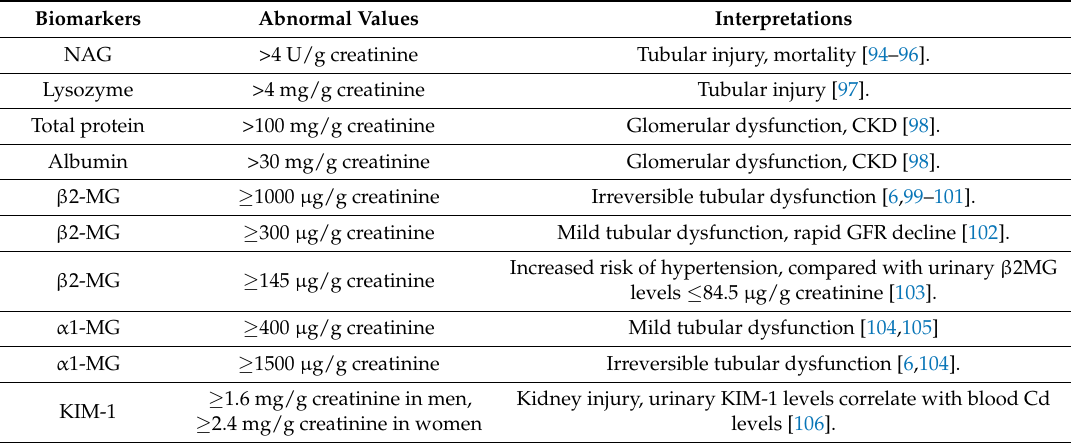
Table 3. Urinary biomarkers for assessment of kidney effects of